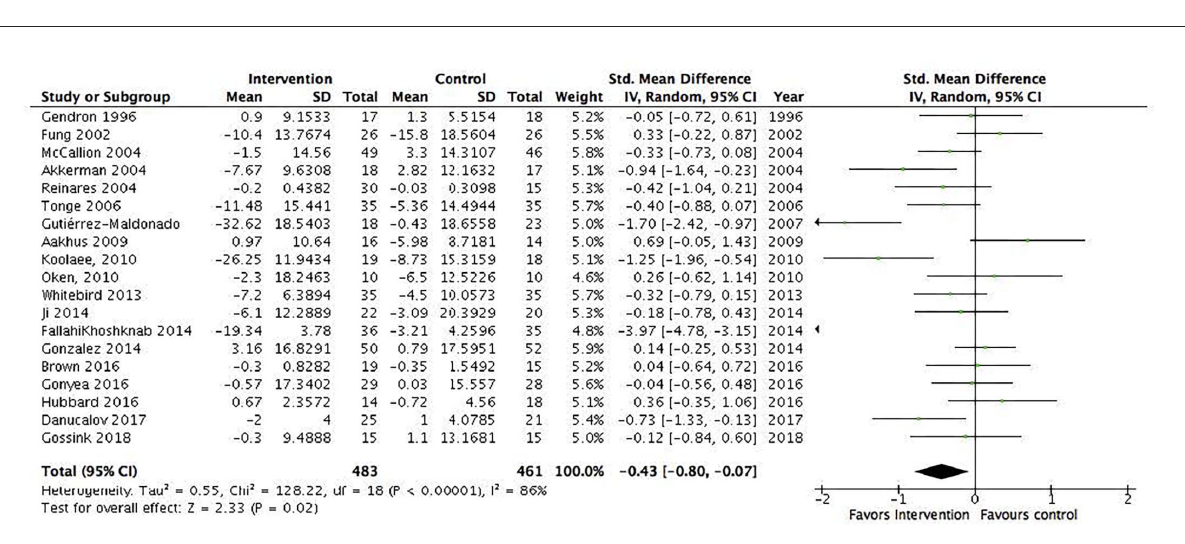
FIGURE7 Subgroup analysis of interventions with a group delivery format: All studies. Mean within-group changes and standardized mean